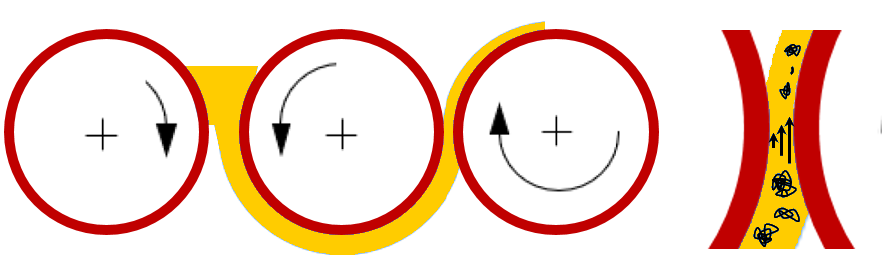
Figure 10. Principle of three-roll mill (TRM) method and shear force transmission within the fluid in the defined gap is decrease agglomerate size.